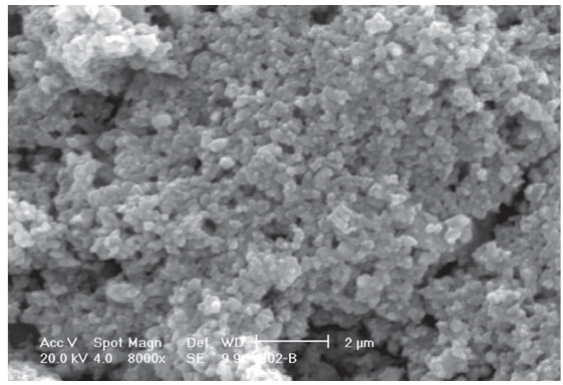
Figure 1. SEM micrograph of La thesis and calcination at 1200